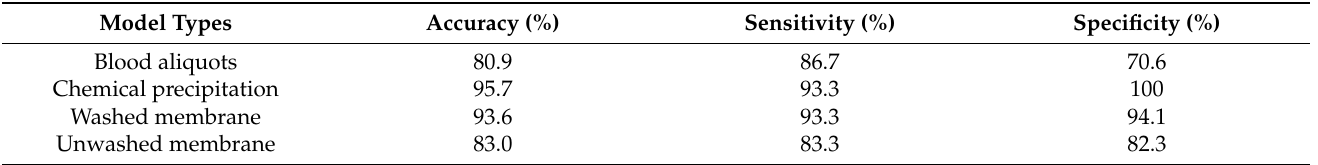
Table 2. Statistical performance results of OPLS-DA models obtained from the portable FT-IR spectral data of samples prepared by four different approaches (blood aliquots, chemical solvent precipitation extraction, and unwashed and washed semi-permeable membrane extractions).